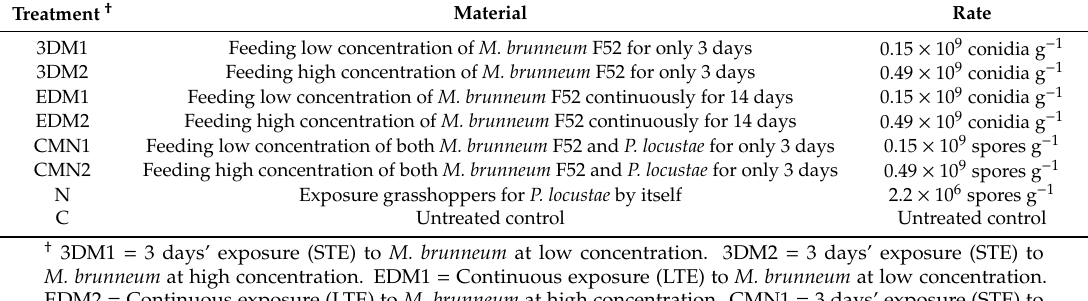
Table 1. Materials and rates of baits for treatment applied in study of 3rd instar grasshopper control. These rates were made according to 2.2 kg ha − 1